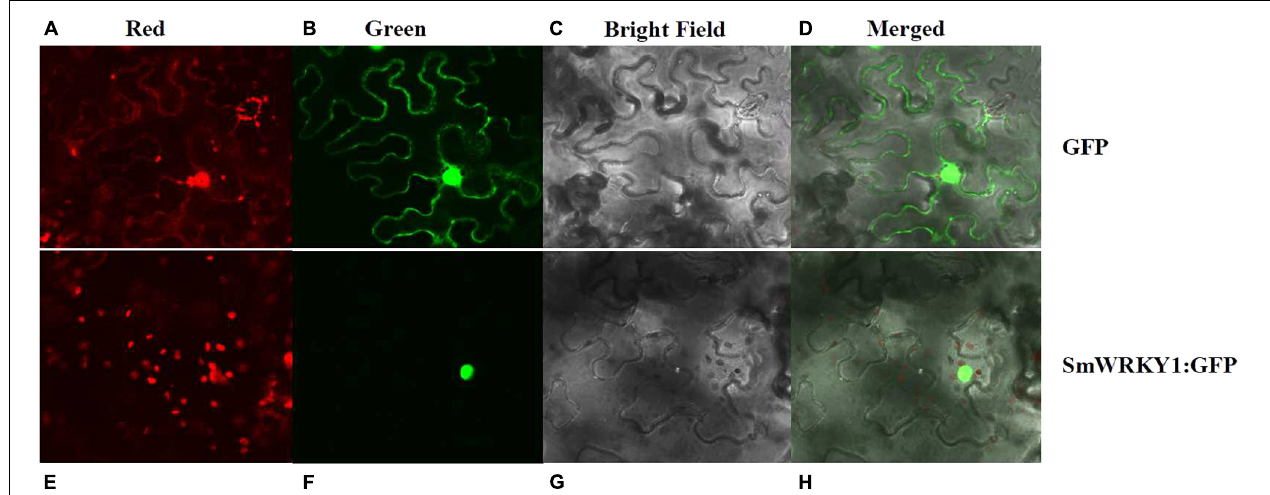
FIGURE 3 | Subcellular localization of SmWRKY1. (A–D) The free GFP expressed in N. benthamiana leaves. (E–H) SmWRKY1:: GFP expressed in N. benthamiana leaves.